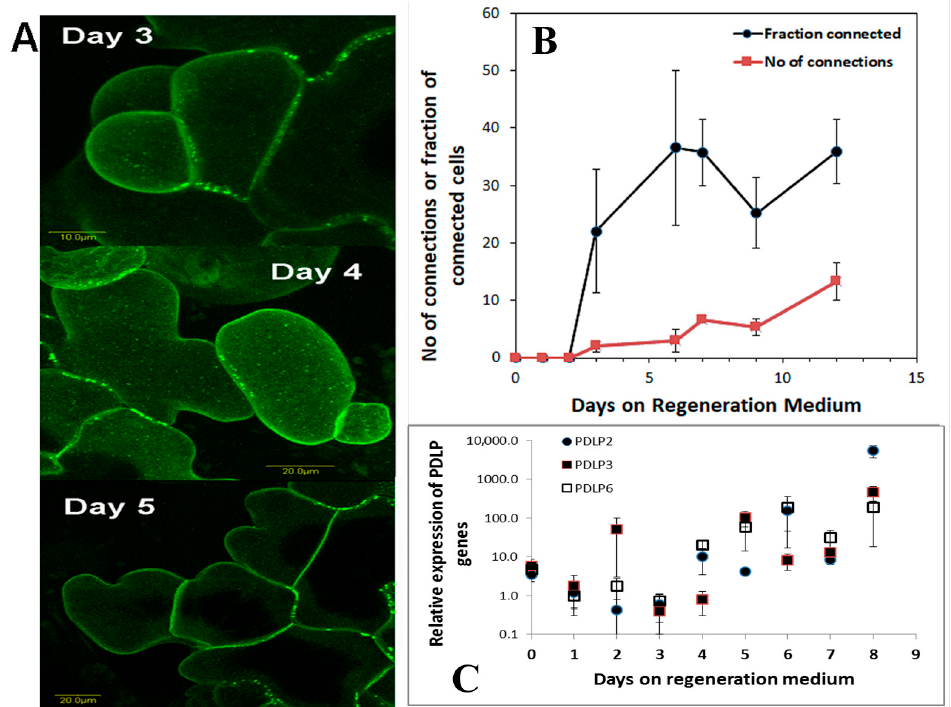
Figure 6. Plasmodesmata during shoot regeneration. ( A ) Leaf segment from tobacco plants that are homozygous to the transgene 35S::AtPDLP5-GFP were placed on Reg medium and samples were removed every day and the new cells were visualized and analyzed using confocal microscopy. ( B ) The number of PD connections per cell was counted and fraction of cells with PD from all new cells was counted. ( C ) Expression pattern of three tobacco PDLP genes during the shoot induction period is depicted. Error bars indicated standard error of 50 cells in B; and 3 biological replicates in ( C ).